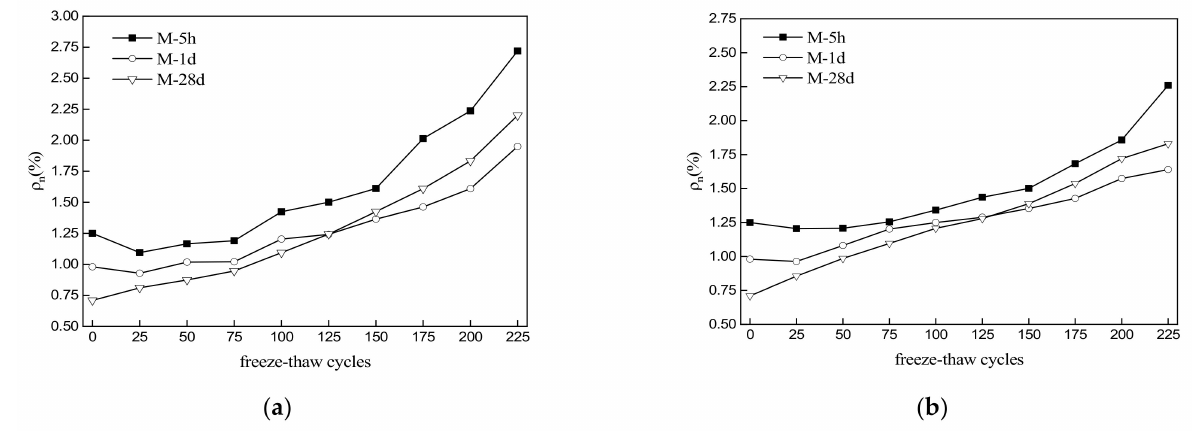
Figure 6. Trends of water absorption rates of MKPC mortar specimens with number of freeze–thaw cycles. ( a ) Freezing and thawing in water. ( b ) Freezing and thawing in 5% Na 2 SO 4